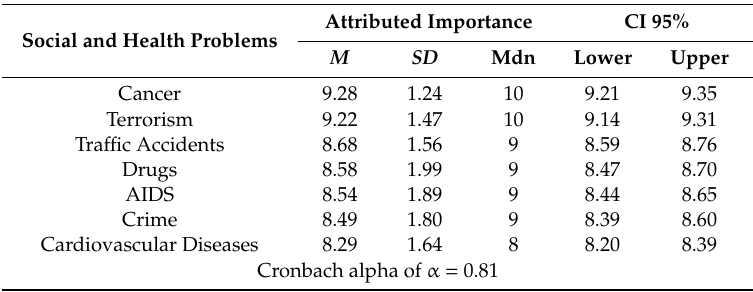
Table 1. Estimated importance of social and health problems by order of